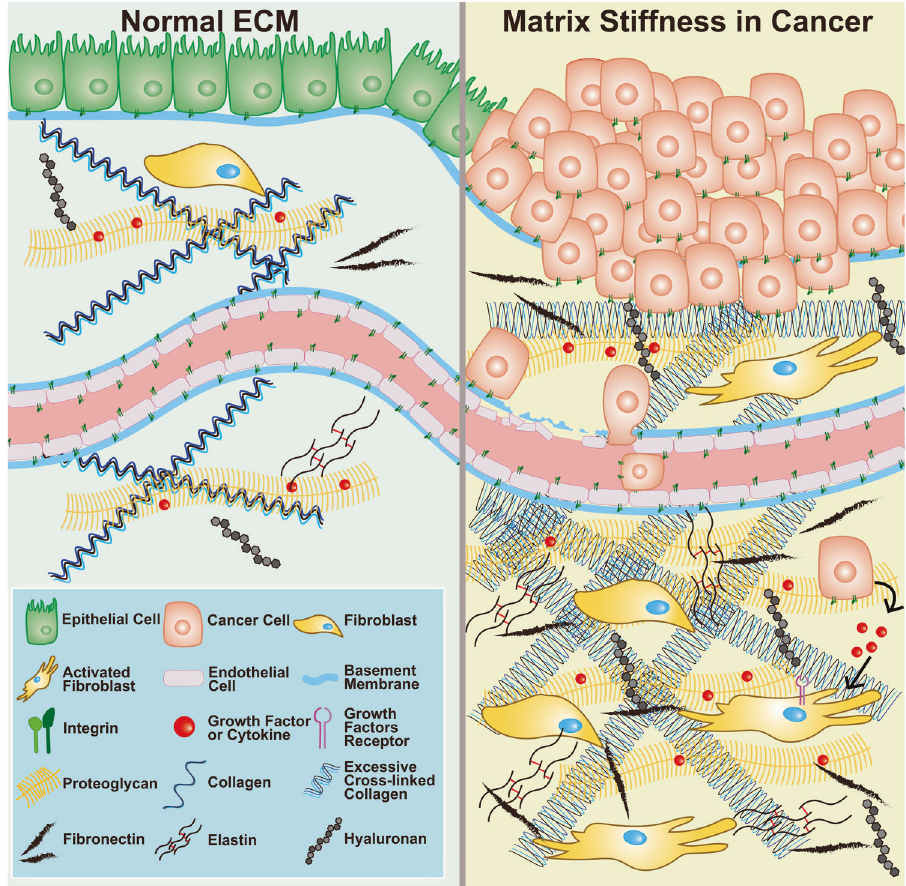
Fig. 1 Schematic illustration of ECM components in normal tissue (left) and the TME (right). Matrix stiffness is mainly related to excessive collagen and HA within TME. Both cancer cells and fi broblasts contribute to the remodeling of the ECM during its stiffness, fundamentally in fl uencing many critical biological processes during the development of